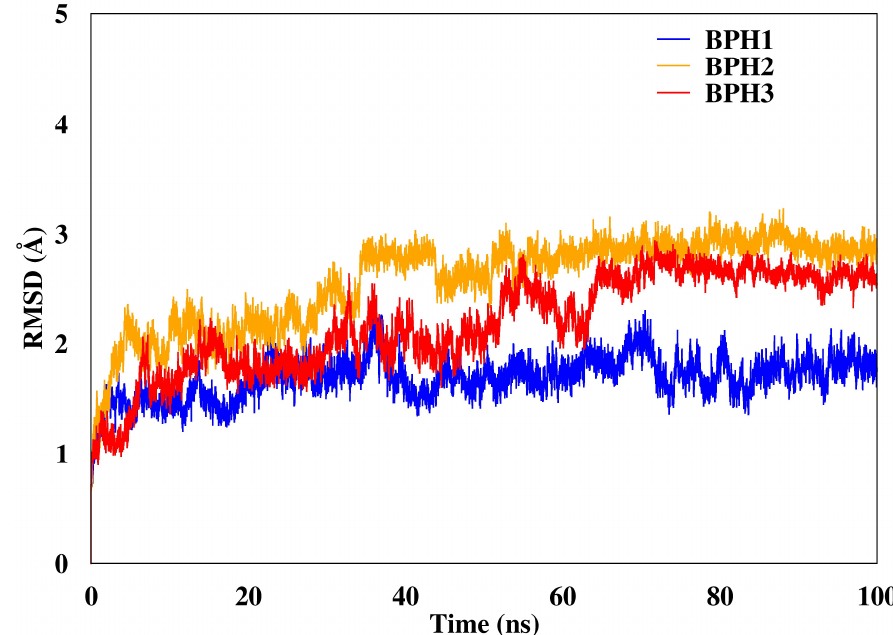
Figure 3. RMSD of the backbone atoms of the complexes after 100 ns of MD simulations. The RMSD represents the enzyme in the presence of the BPH1 (blue), BPH2 (yellow), and BPH3 (red) inhibitors. Regarding the fluctuations observed for the three complexes, the BPH3-KDO8P synthase complex, particularly residues 200–218 (loop L8), showed slightly higher fluctuations (Figure 4) than others did.